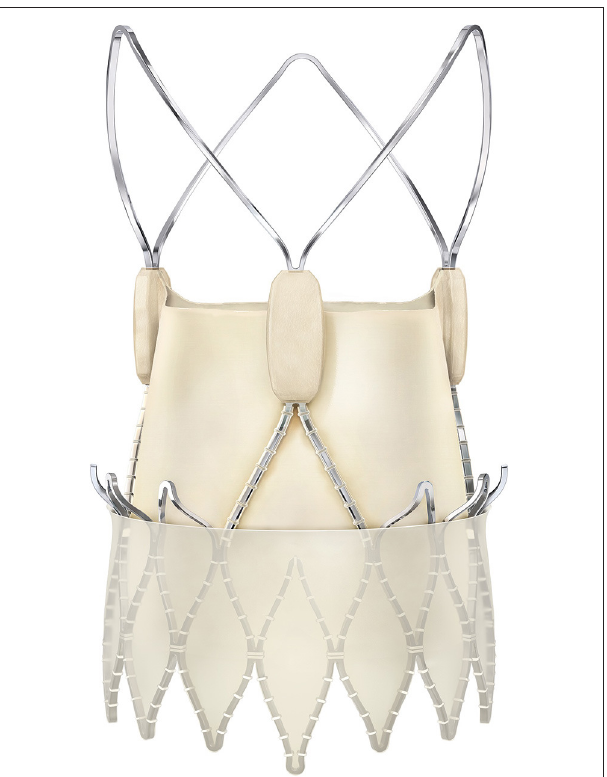
FIGURE 1 | The self-expandable Acurate neo 2 THV. Latest generation self-expandable transcatheter heart valve consisting of a Nitinol stent carrying a porcine pericardial bioprosthesis in supra-annular position, deployment is carried out in a top-down fashion with opening of the upper crown and stabilization arches as first step for stable positioning and coaxial alignement and deployment of the lower valve stent for anchoring in the aortic annulus. Image provided courtesy of Boston Scientific. © 2021 Boston Scientific Corporation or its affiliates. All rights reserved. The usage of Acurate neo2 TM in aortic insufficiency is off-label